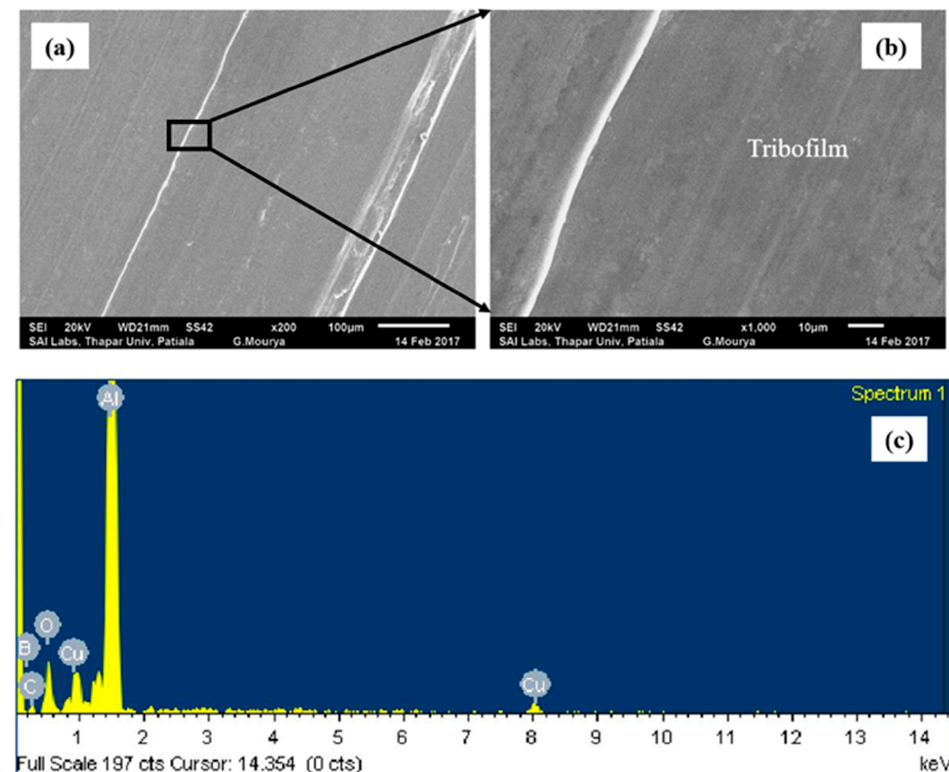
Figure 7. ( a ) SEM image of worn surface of the aluminium alloy disc lubricated with PAO + CuO + ND nanolubricant at 50 N load (200×) ( b ) magnified image (1000×) of Figure 7a; and ( c ) EDS spec- trum of Figure 7a. Tribofilm formation can be seen on the worn surface. In the EDS spectrum, car- bon (C) peak indicates the presence of ND particles on the worn surface.